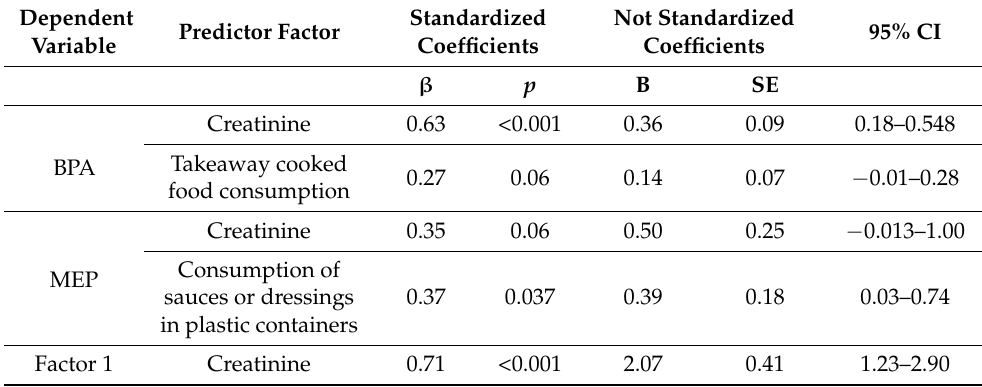
Table 7. Multivariable analysis models (multivariable